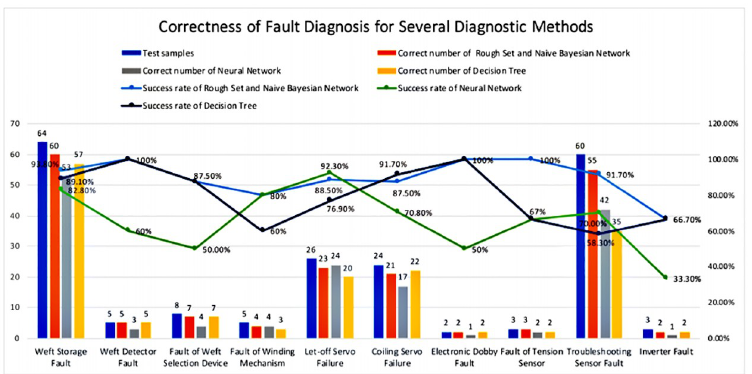
Fig 4. Comparison of the effect of fault diagnosis